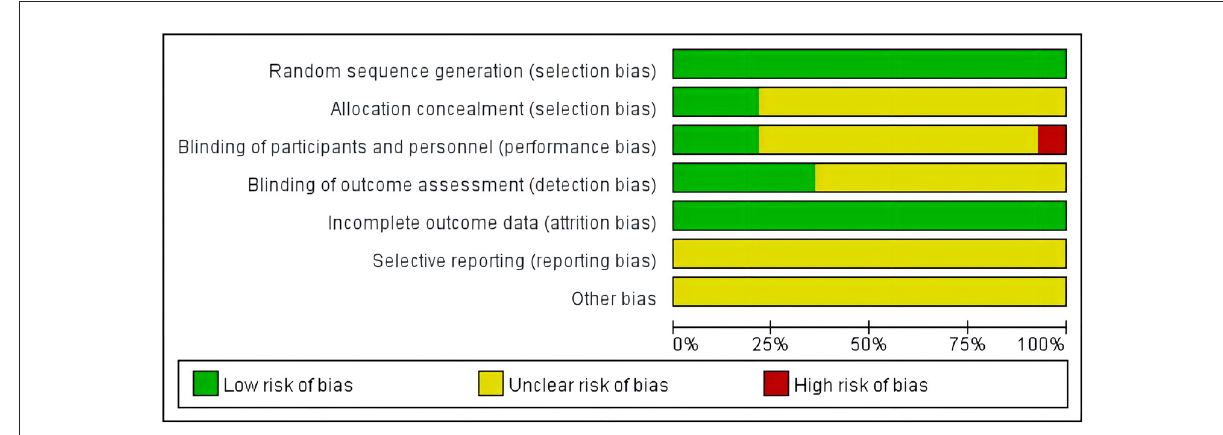
FIGURE2 Risk of bias graph: judgements about each risk of bias item presented as percentages across all included studies.